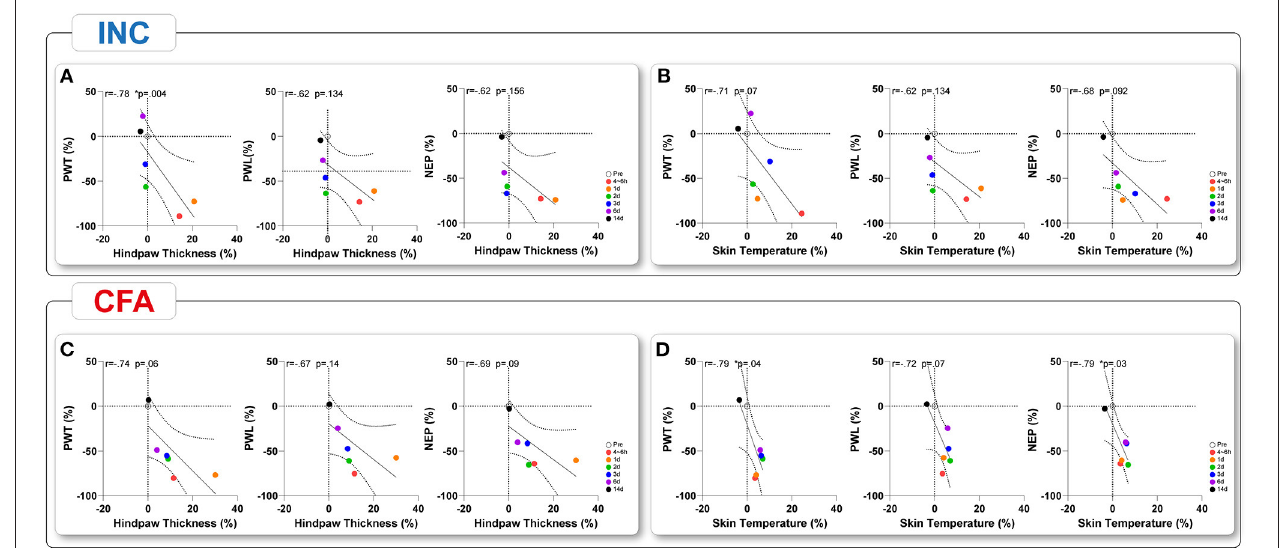
FIGURE 5 | Time-dependent correlation analysis of the macroscopic inflammatory response parameter with reflexive-based withdrawal behavior to mechanical and heat stimuli and non-evoked behavior. (A) Upon INC, only the hindapw thickness was time-dependently correlated with PWT, (B) while hindpaw skin temperature did not show significant correlations. (C) No significant correlation were found between behavioral outcomes and hindpaw thickness in CFA mice but (D) between behavioral outcomes and skin temperatures. Linear regression (solid line) with 95% CI (dotted line) is displayed. Values of p : * p < 0.05, ** p < 0.01, *** p < 0.001 by Spearman (two-tailed) coefficients were used to determine relationships between the multiple parameters. Correlation analyses were performed after first computing the mean of side-by-side replicates and then analyzing those